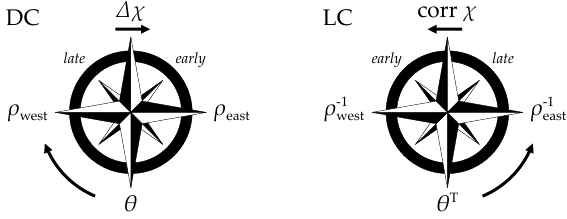
Figure 6: Conventions for differential (DC) and linear (LC) trails in the round